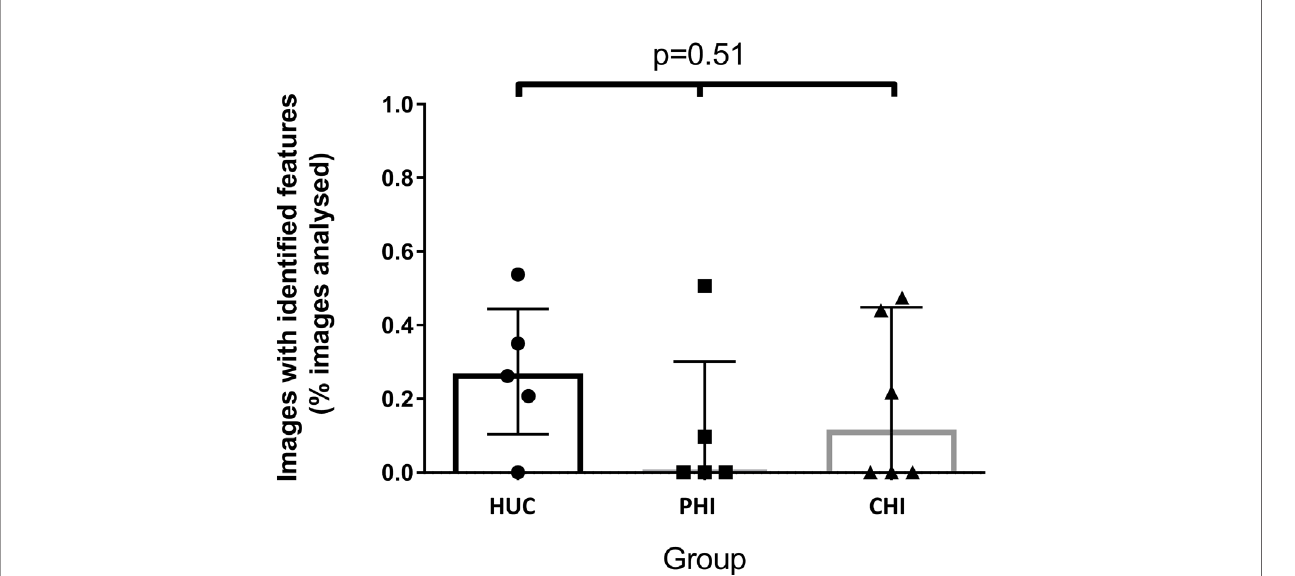
FIGURE 3 | Images with identi fi ed confocal endomicroscopy features ( fl uorescein leak and cell junction enhancement) as a percentage of total images analysed for the participant, across three groups. Median percentage of images was 0.26% for HIV-uninfected controls (HUC), 0.00% for HIV-positive participants treated in primary infection (PHI), and 0.11% for HIV-positive participants treated in chronic infection (CHI). Statistical analysis was conducted using Kruskal Wallis one-way analysis of variation.